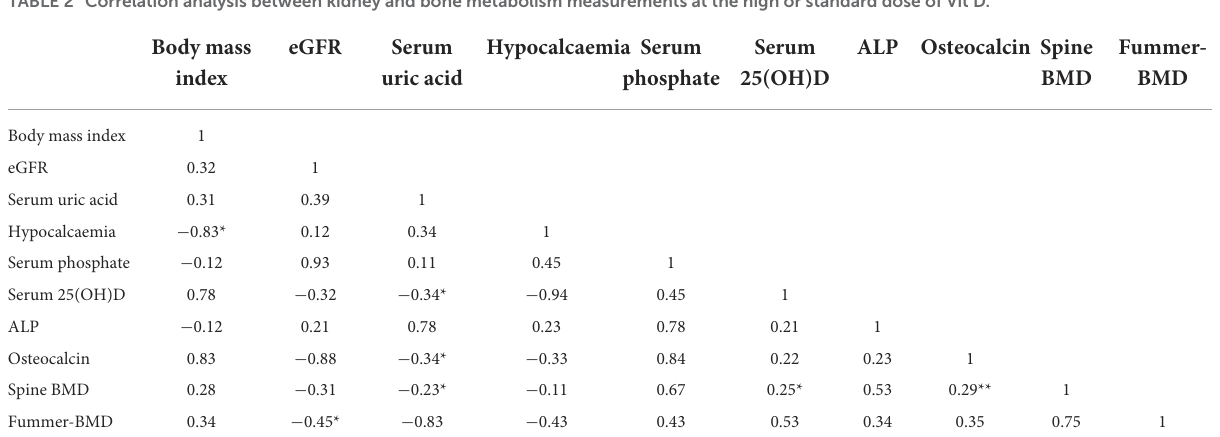
TABLE 2 Correlation analysis between kidney and bone metabolism measurements at the high or standard dose of Vit D.